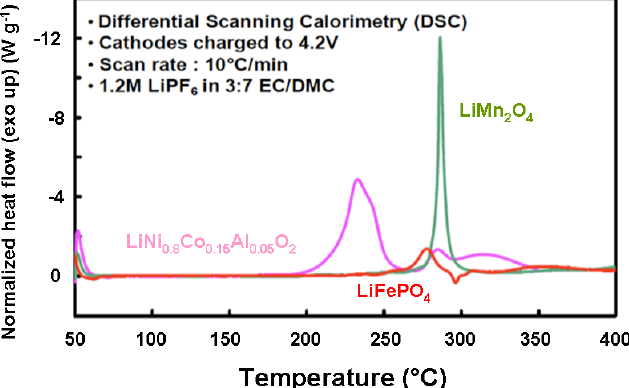
Figure 10. DSC spectra of over charged layered, spinel and olivine cathodes with traces of